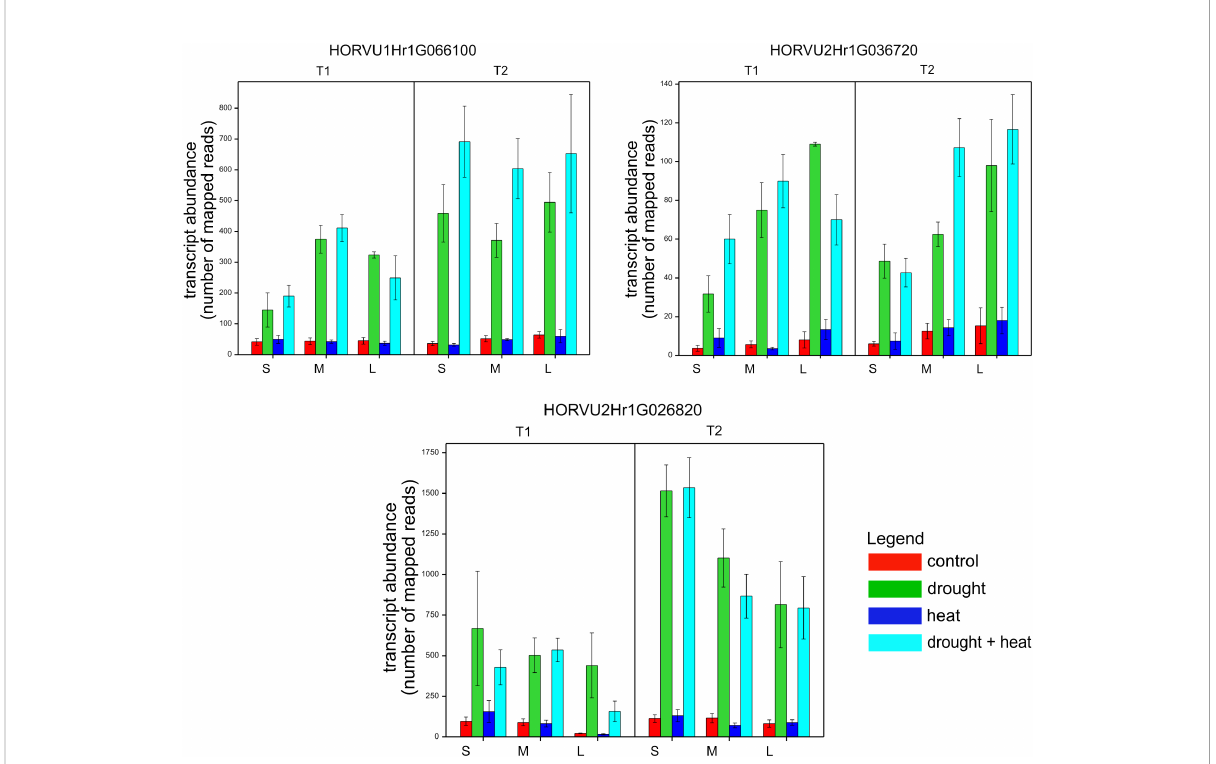
FIGURE 5 Mean expression levels (counts of mapped reads) for three genes in genotypes of different fl ag leaf size (S, small; M, medium; L, Large) in two time points (T1 and T2), whose reactions to stresses correlated with reaction with respect to grain weight per plant